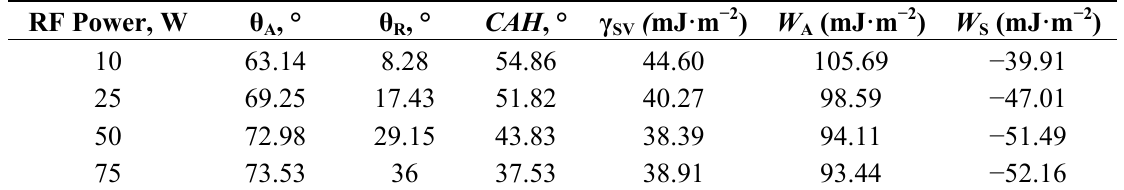
Table 3. Wettability parameters of pp–GT thin films deposited at various RF power derived from contact angle hysteresis (CAH).